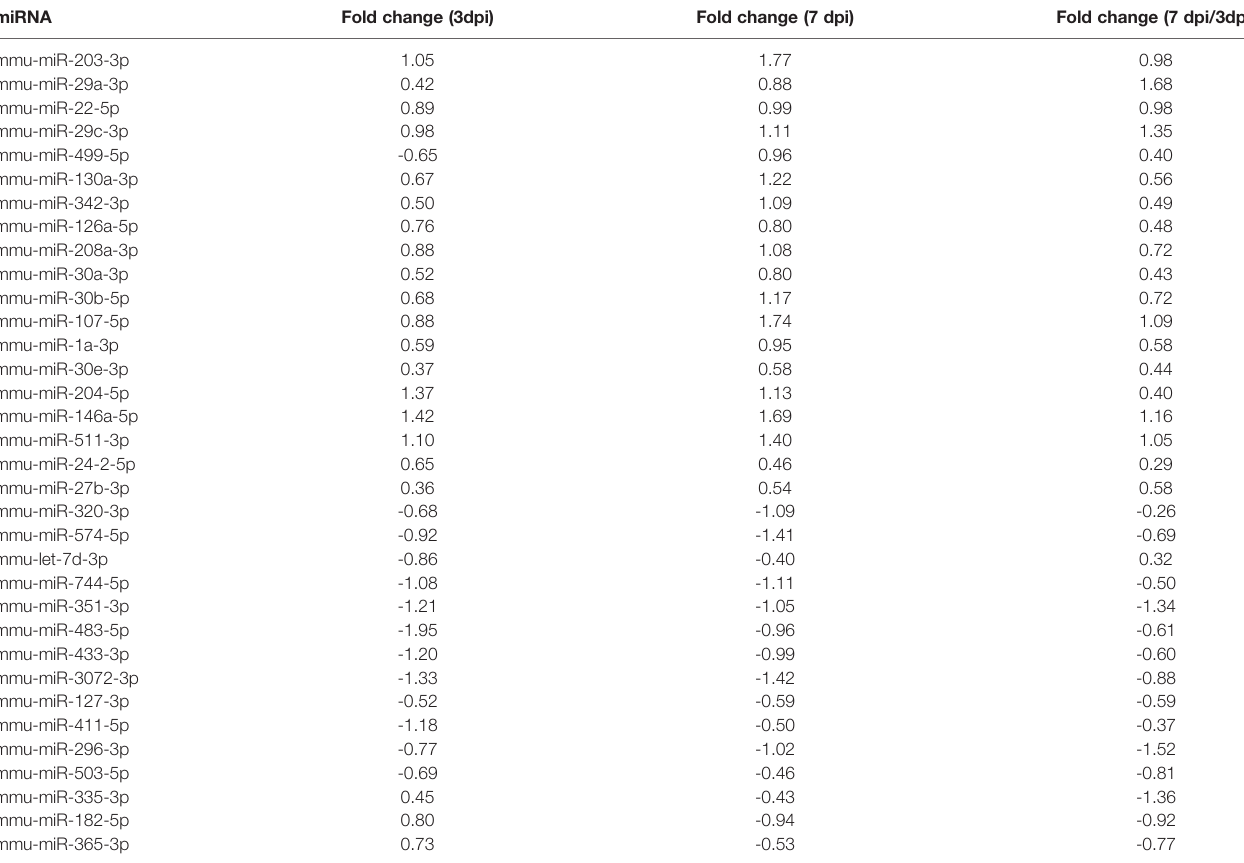
TABLE 2 | The differential co-expressed miRNAs. miRNA Fold change (3dpi) Fold change (7 dpi) Fold change (7 dpi/3dpi) mmu-miR-203-3p